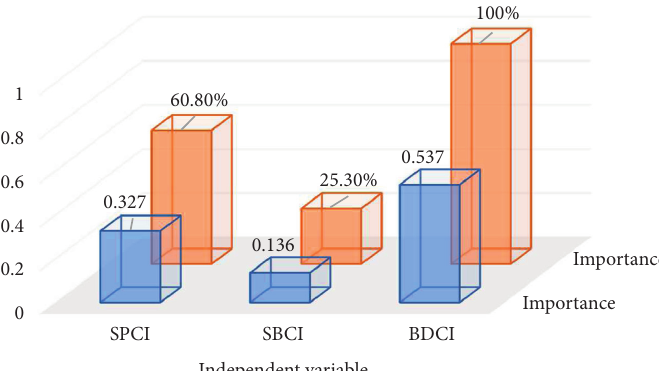
Figure 9: Importance of independent